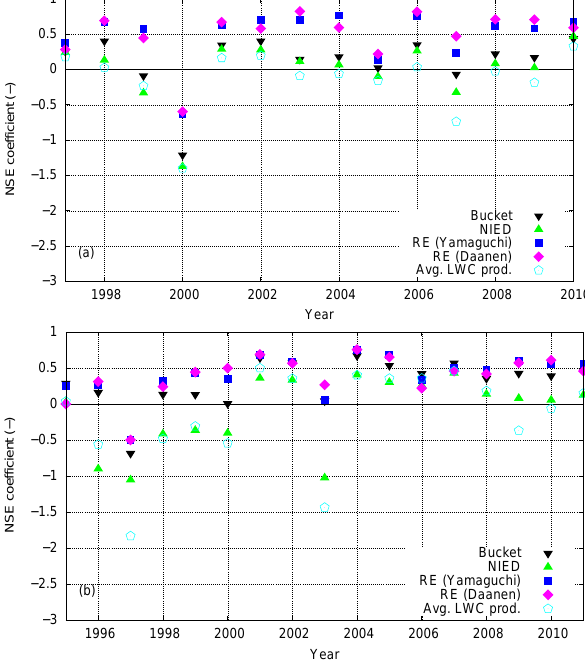
Fig. 5. NSE coefficients (model vs. measured) over all snow seasons for the studied water balance schemes for different sub-daily time scales for WFJ (a) and CDP (b) .